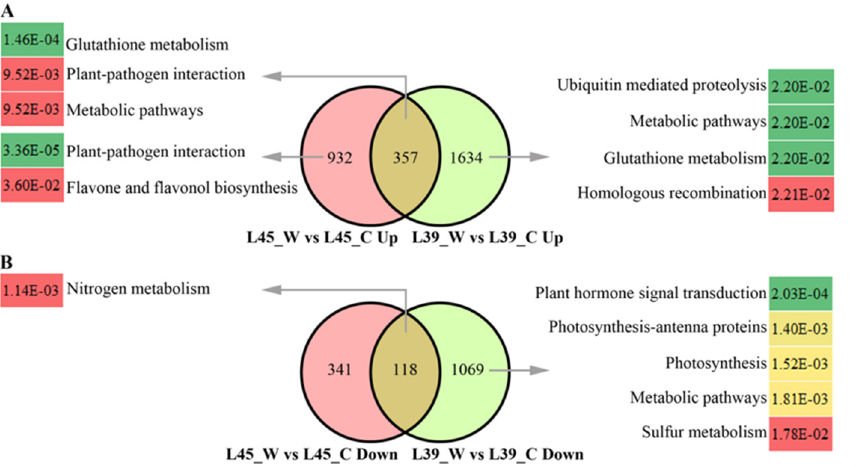
Figure 6. Venn diagrams of up-regulated ( A ) and down-regulated ( B ) DEGs and the highly enriched KEGG pathways.